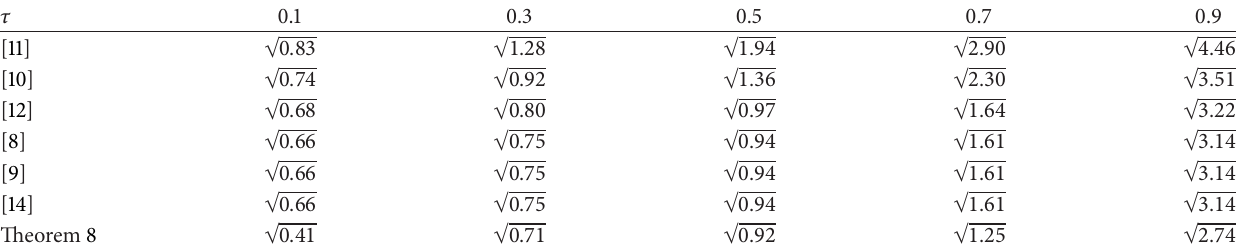
Table 6: Computed 𝑟 ’s of Example 4 for different values of 𝜏 with 𝜇 = 0